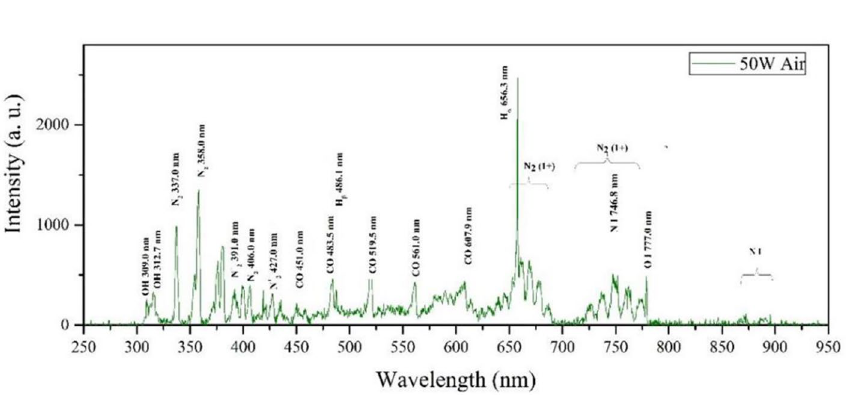
Figure 2. Optical spectra emitted from RF plasma for powers 50